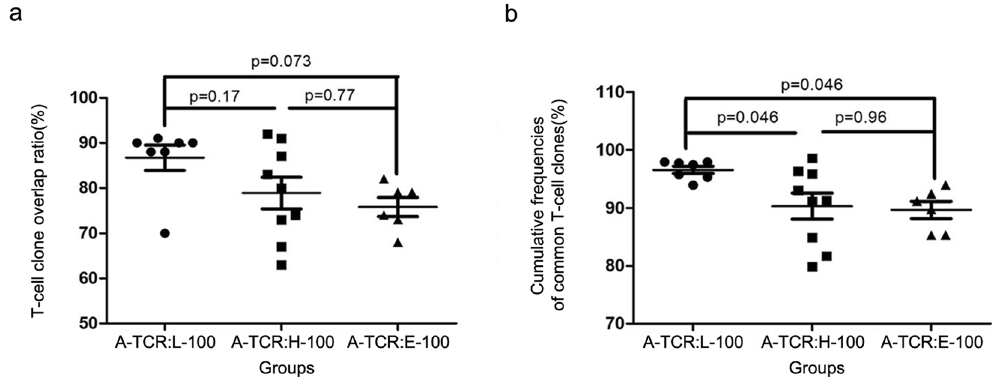
Figure 3. Comparison of the overlap between the TOP100 of gastric lesions and A-TCR. The T-cell clone overlap ratio ( a ) and the cumulative frequencies of common T-cell clones ( b ) between A-TCR and L-100 were significantly higher than those between A-TCR and H-100 and between A-TCR and E-100. One-way ANOVA and Tukey’s post hoc multiple comparison test, p < 0.05.